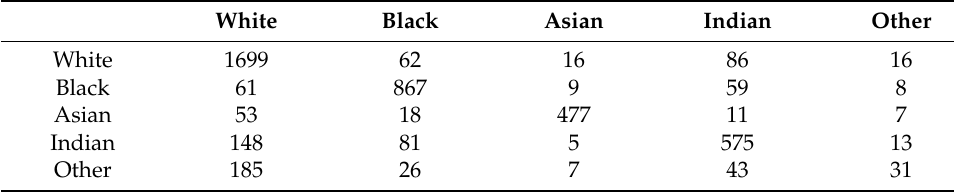
Table 14. Confusion matrix for the UTKFace filtered testing with plotted